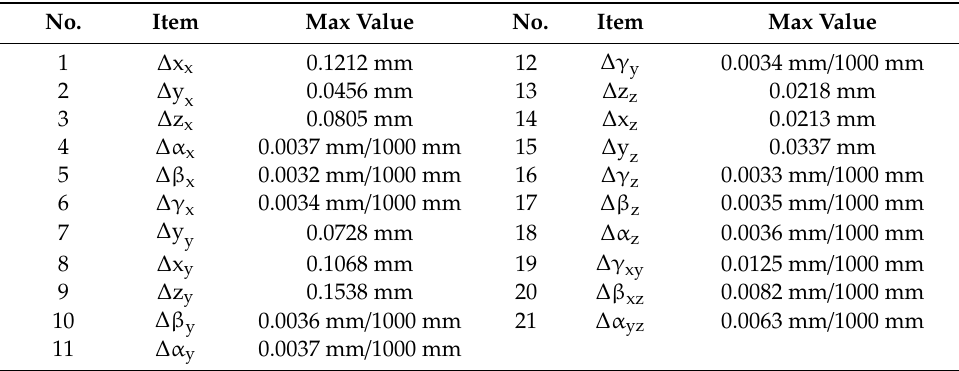
Table 5. Max error value in the whole